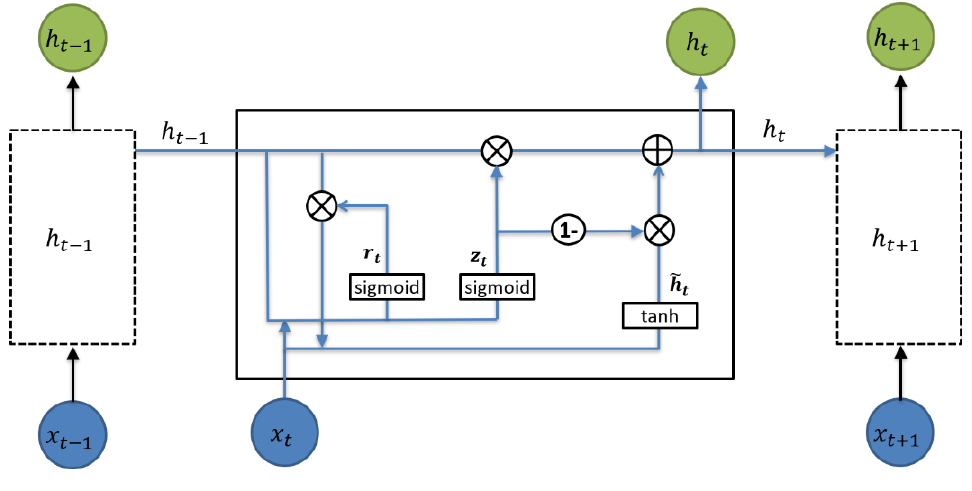
Figure 5. GRU model.